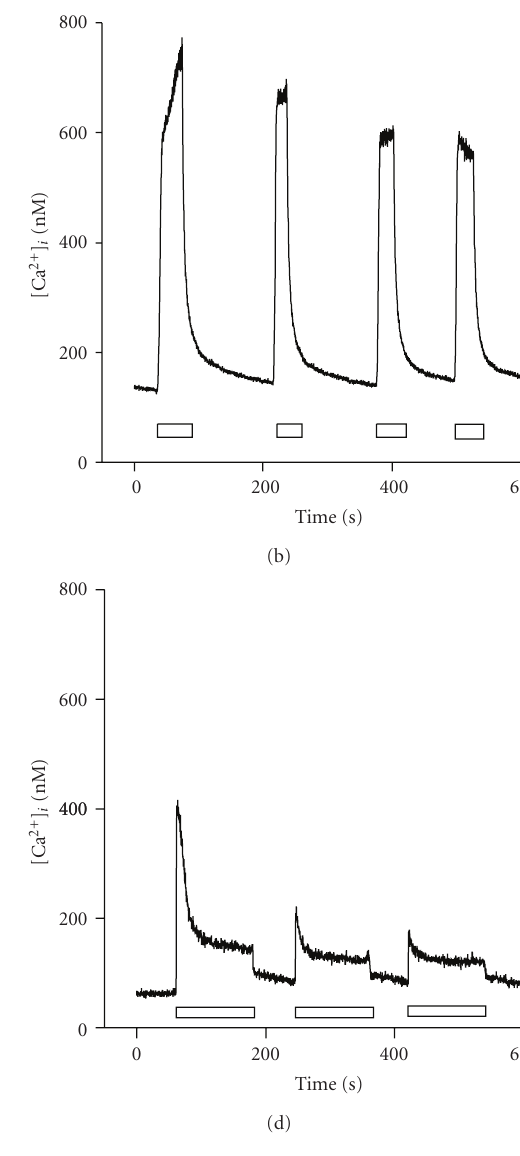
Figure 2: E ff ect of ca ff eine on [Ca 2+ ] i in isolated myoblasts and myotubes. Representative traces show the typical time course of the response to 20 mM ca ff eine observed in (a) wild type (+/+) myoblast; (b) wild type (+/+) myotube; (c) capn3 -deficient ( − / − ) myoblast; (d) capn3 - deficient ( − / − ) myotube. The duration of drug exposure is represented (open